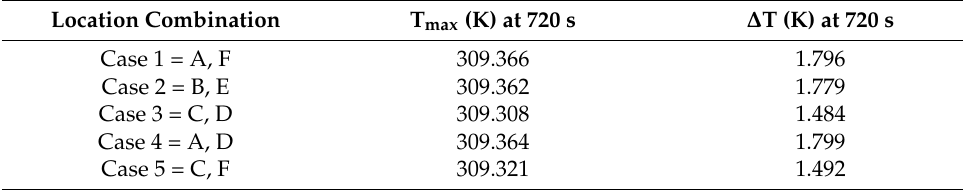
Figure 9. Inlets (A–C) and outlets (D–F) locations (dimensions in mm)–LCD. Table 4. Thermal performance of location combinations at t = 720